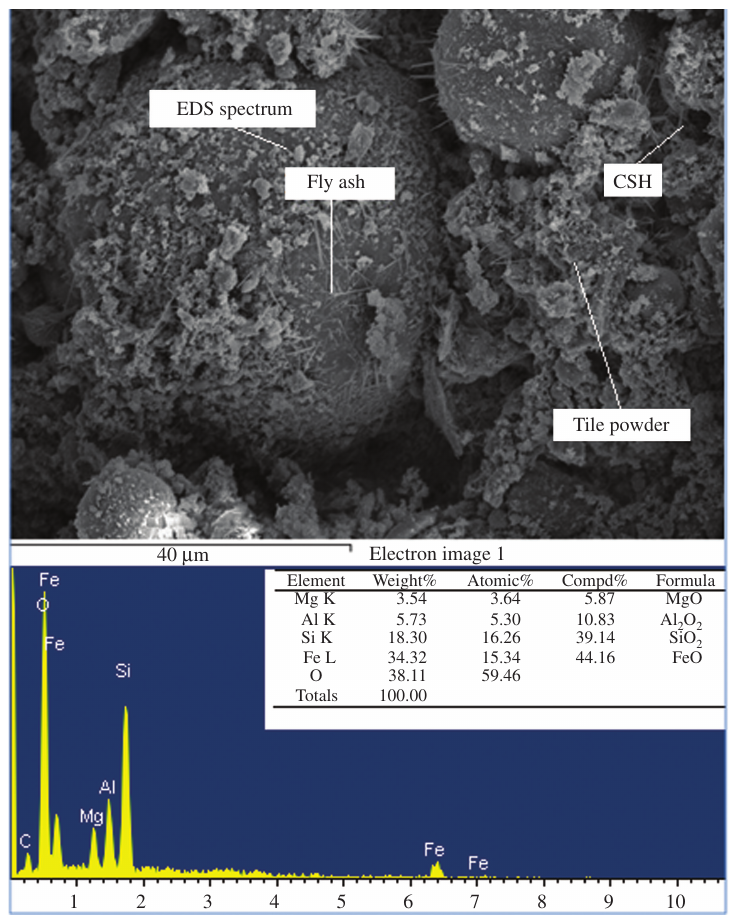
Figure 8 Secondary electron image of FA and